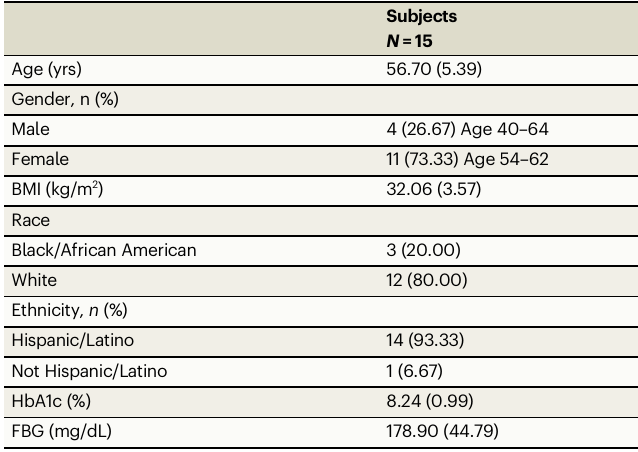
Table 1 | Demographic characteristics of study